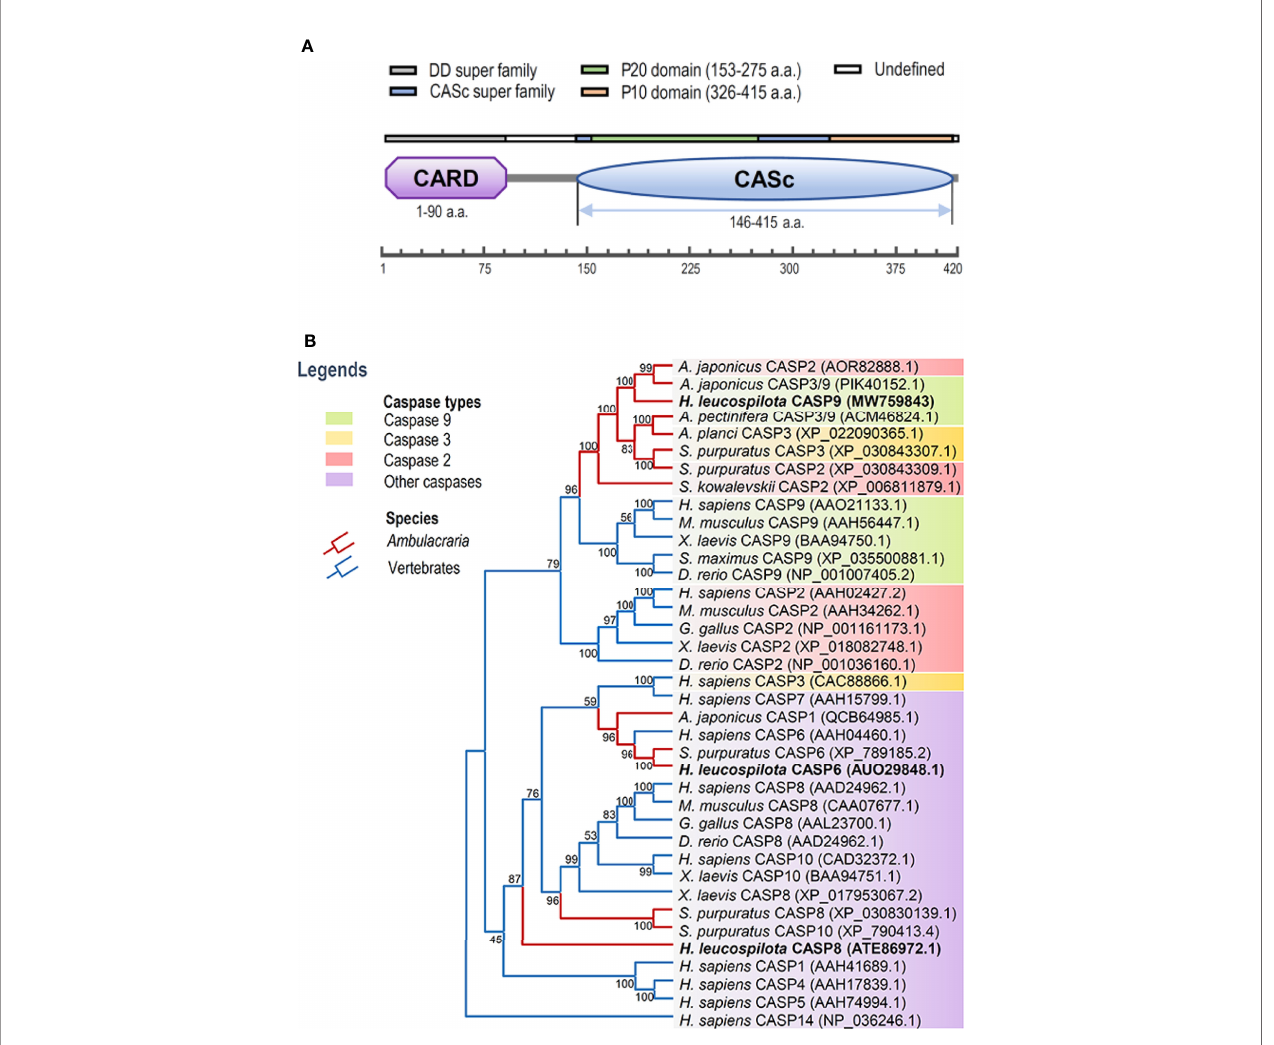
FIGURE 1 | Functional domains of Hl-CASP9 and its evolutionary relationships with other caspases. (A) Structural domains of Hl-CASP9 predicted by using the SMART and ScanProsite programs. (B) Phylogenetic analysis of caspases among various species by using Neighbor-Joining method with bootstrap value of